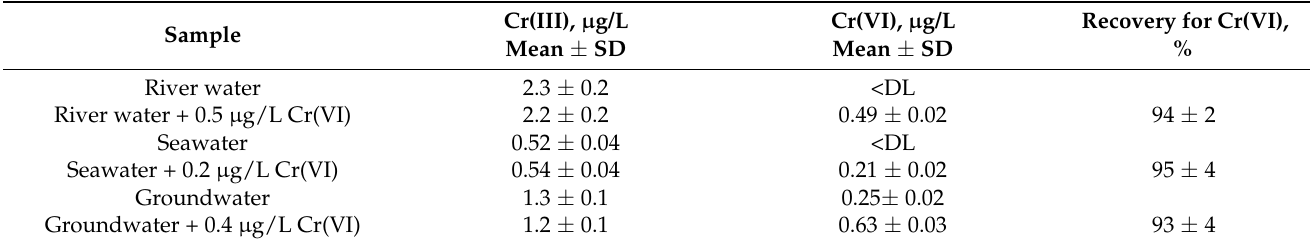
Table 4. Determination of Cr(III) and Cr(VI) in different types of waters (three parallel